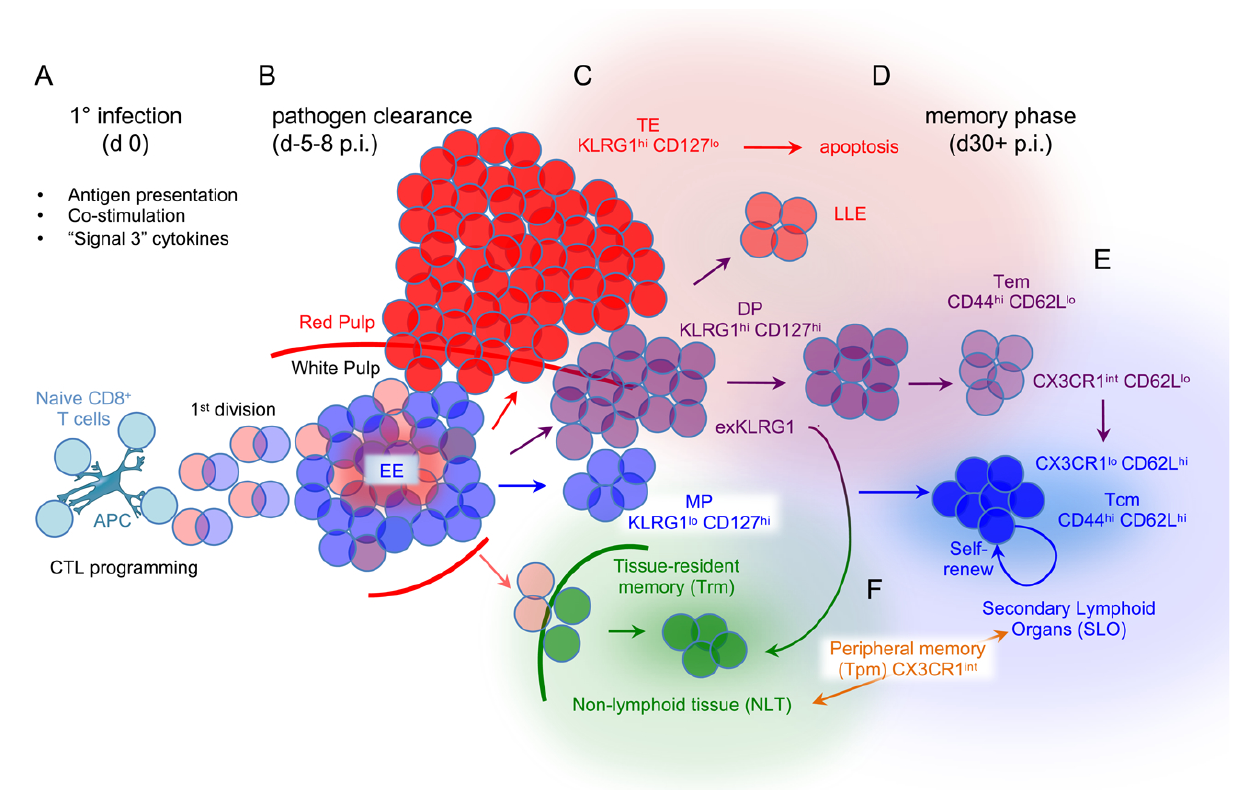
Figure 1. Patterns and inter-relationships of effector and memory CD8 T-cell subsets induced by acute intracellular infection. ( A ) Antigen presentation, co-stimulation, and additional inflammatory signals induce multiple individual naïve CD8 T cells to undergo a prototypical pattern of geometric expansion. ( B ) Individual cells within the nascent CTL population of early effector (EE) cells differentiate along any one of multiple trajectories. ( C ) Multiple phenotypic subsets with distinct memory CD8 T-cell potentials are detectable at the peak response, near the time when most pathogen has been eliminated. Cells that are KLRG1 hi CD127 lo have the shortest half-lives after the infection resolves and are referred to as short-lived effector cells (SLECs) or simply terminal effector (TE) CD8 T cells (red). Conversely, KLRG1 lo CD127 hi cells are termed memory precursor (MP) effector CD8 T cells (light blue) because they most efficiently generate memory CD8 T cells. However, some double-positive (DP) effector cells that are KLRG1 hi CD127 hi9 (purple) downregulate KLRG1 and give rise to memory CD8 T cells. Trm precursors (light green) derived from KLRG1 lo intermediates in the spleen begin populating non-lymphoid tissues (NLTs) near the peak response. ( D ) Most TE cells persist poorly into the memory phase. At early memory time points, some KLRG1 hi cells persist and have been termed effector-like memory cells or long-lived effector (LLE) cells but they wane over time. Tem cells preferentially localize in the vasculature (light red background), some of which convert into Tcm cells (dark blue) that reside in secondary lymphoid organs (light blue background) later during the memory phase. Arrows indicate the general ancestry of the different cell populations and are colored according to the main classes of effector and memory CTL